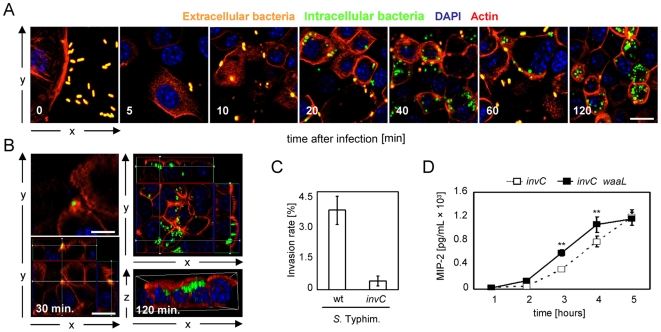
Delayed activation by wildtype Salmonella is independent of bacterial invasion.(A) m-ICcl2 cells were coincubated with constitutively GFP-expressing wildtype S. Typhimurium for the indicated time points, fixed, and visualized by immunostaining using a mixture of two mouse monoclonal anti-Salmonella O-antigen (anti-O4 and anti-O5) antibodies in combination with a Texas-red-conjugated secondary antibody (red) in the absence of cell permeabilization. This facilitates the differentiation of intracellular bacteria (green) and extracellular bacteria (green plus red = orange). Counterstaining was performed using TR-phalloidin (red), and Dapi (blue), to reveal the cytoskeleton and the nuclei, respectively. Scale bar, 5 µm. (B) The invasive behaviour (left panel), and intracellular presence (right panel) of wildtype S. Typhimurium in m-ICcl2 cells is illustrated 30 min and 2 hours after infection. The lower right image shows a three-dimensional reconstruction of the polarized epithelial cell layer from a lateral view. Bar, 5 µm. (C) The non-invasive phenotype of a S. Typhimurium invC mutant was verified on m-ICcl2 cells using a Gentamicin protection-assay. (D) Kinetics of MIP-2 secretion by m-ICcl2 cells exposed to O-antigen positive non-invasive invC mutant Salmonella as compared to O-antigen negative non-invasive invC waaL double mutant Salmonella [MOI 10∶1]. **, p<0.01.